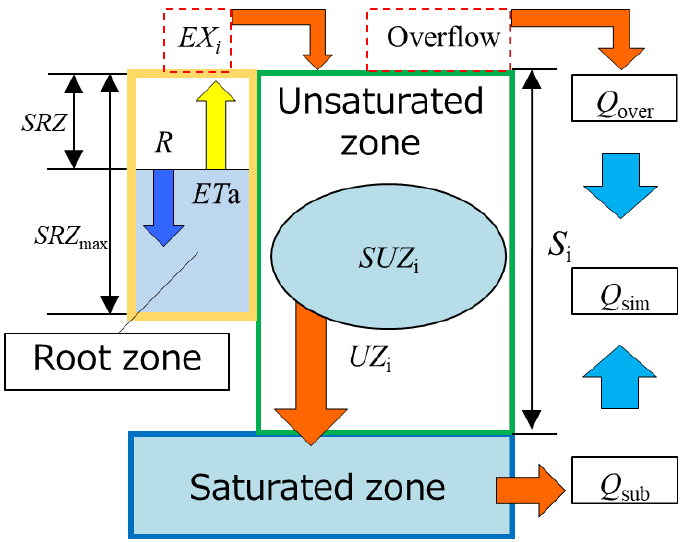
Figure 4. Schematic of the TOPMODEL concept [46]. SRZ (storage in the rootzone); SRZ max (maximum rootzone storage deficit); S i (local storage deficit); SUZ i (storage in the unsaturated zone); UZ i (drainage flux); Q sim (simulated discharge); Q over (overland flow); Q sub (subsurface